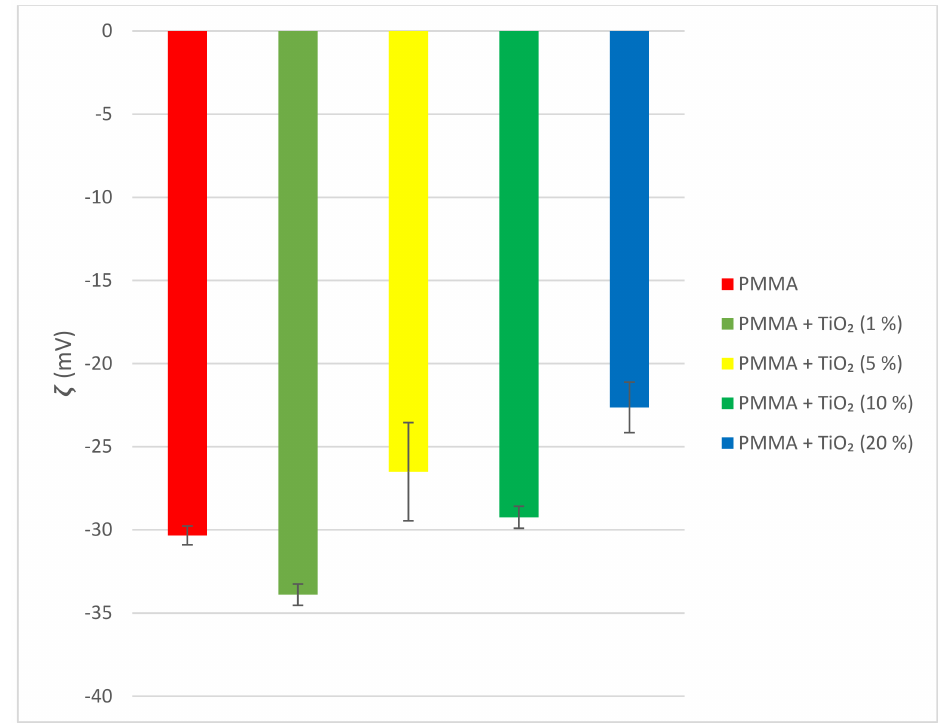
Figure 4. Zeta potentials of all PMMA/TiO 2 NPs surfaces.